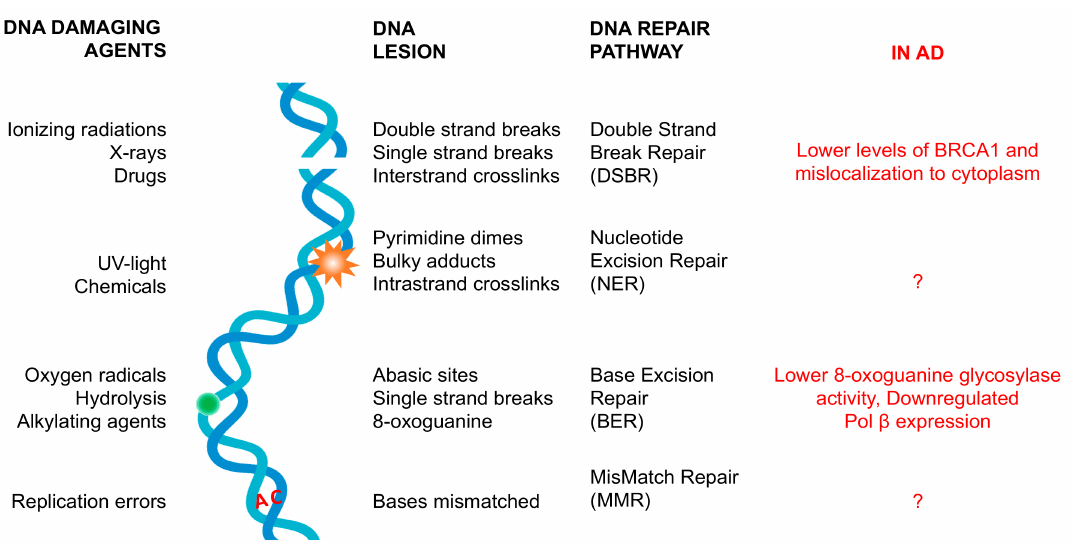
Figure 1. Types of DNA lesions, their DNA repair pathways and possible connections with Alzheimer’s Disease (AD). The principle and well-characterized DNA damage repair pathways are double-strand break repair (DSBR), nucleotide excision repair (NER), base excision repair (BER) and mismatch repair (MMR). DSBR- and BER-specific mutations have been associated with AD